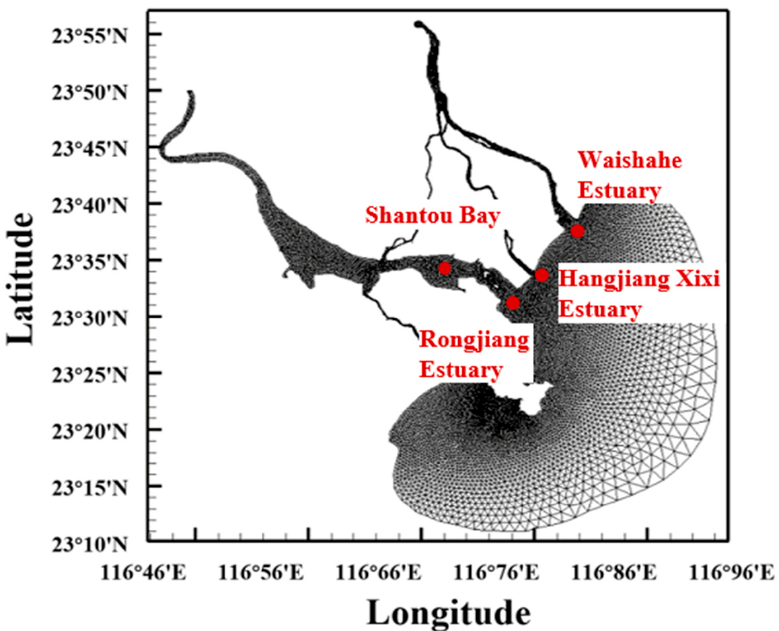
Figure 1. Grid of sediment transport